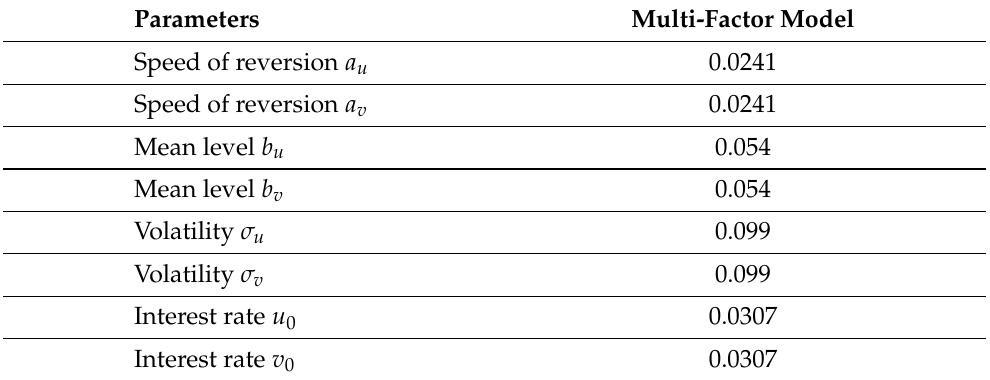
Table 7. Parameters considered in the multi-factor model for cat bond